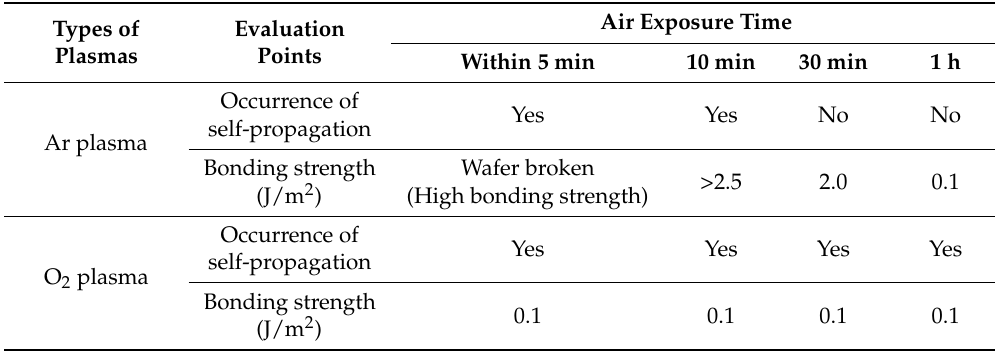
Table 3. Effect of air exposure time on the occurrence of self-propagation of the bonding area and on the bonding strength of surface activated